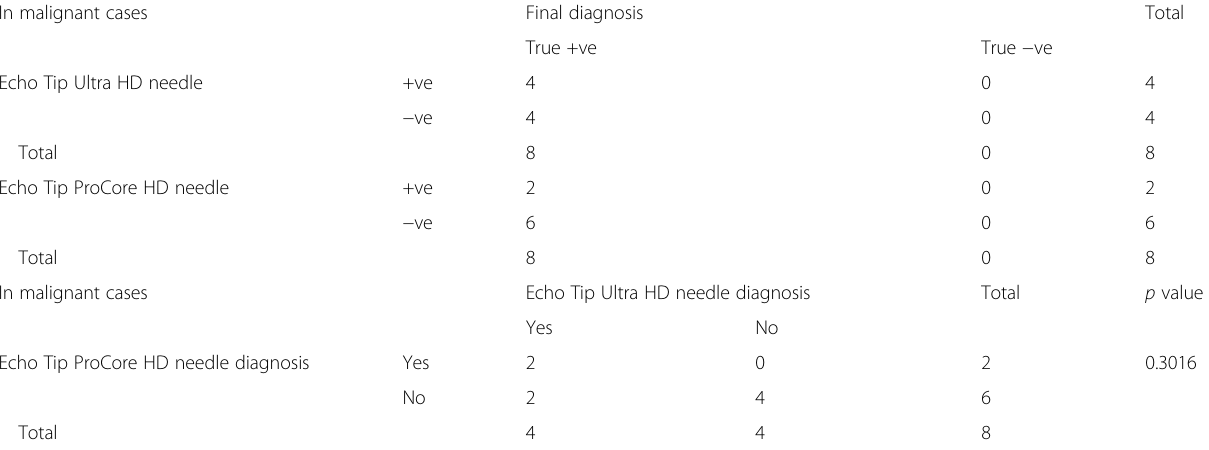
Table 3 Sensitivity, specificity, predictive value, and diagnostic accuracy of both needles in malignant cases